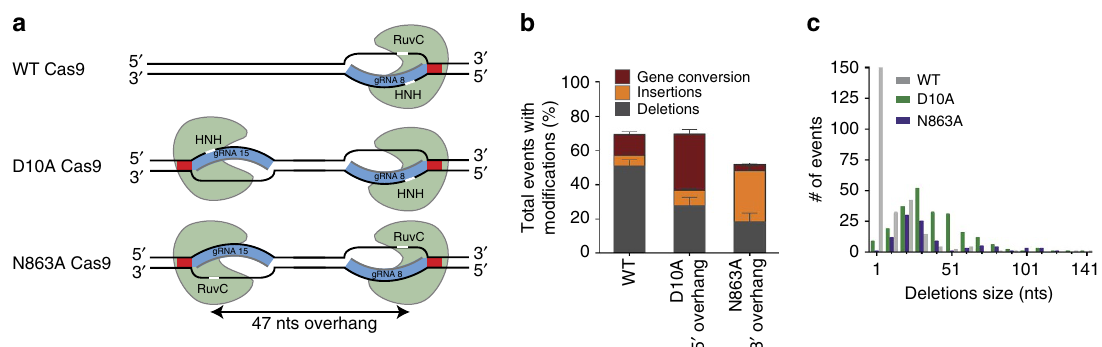
Figure 1 | DNA lesions introduced by different Cas9 variants result in different repair outcomes. ( a ) Schematic of lesions introduced by either WT Cas9, D10A Cas9 or N863A Cas9 with gRNAs 8 and 15 (blue). The active nuclease domains are indicated for the respective mutants. PAMs are shown in red. The cut site is in white. ( b ) Overall modification frequency at the HBB locus separated into deletions, insertions and gene conversion events. The different repair outcomes after WT, D10A or N863A Cas9 activity in U2OS cells were measured by PCR amplification of the HBB locus, followed by Sanger sequencing of individual amplification products. Error bars were derived from five independent experiments. Data are represented as mean ± s.e.m. Total number of sequences analysed was 569, 718 and 556 for WT Cas9, D10A Cas9 and N863A Cas9, respectively. ( c ) Plot of deletion size for WT (grey), D10A (green) and N863A (purple) Cas9 variants with gRNA 8 and 15 or only gRNA 8 in case of the WT Cas9. Individual deletion size data from each Cas9 variant were scored from Sanger sequencing and the total number of sequences analysed was 258, 241 and 103 for WT Cas9, D10A Cas9 and N863A Cas9, respectively.